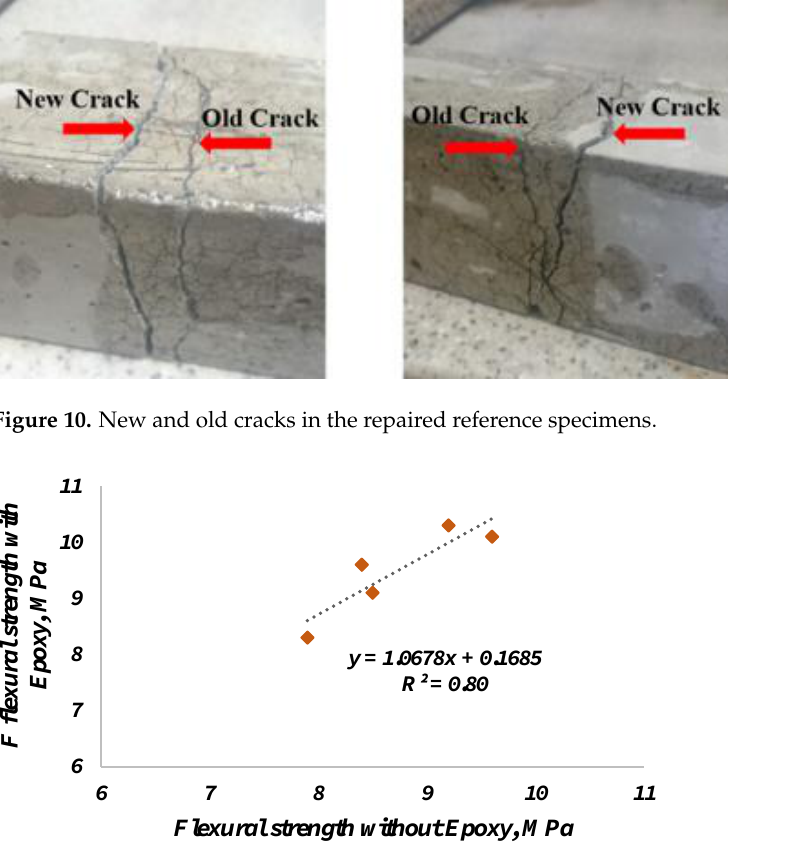
Figure 10. New and old cracks in the repaired reference specimens.